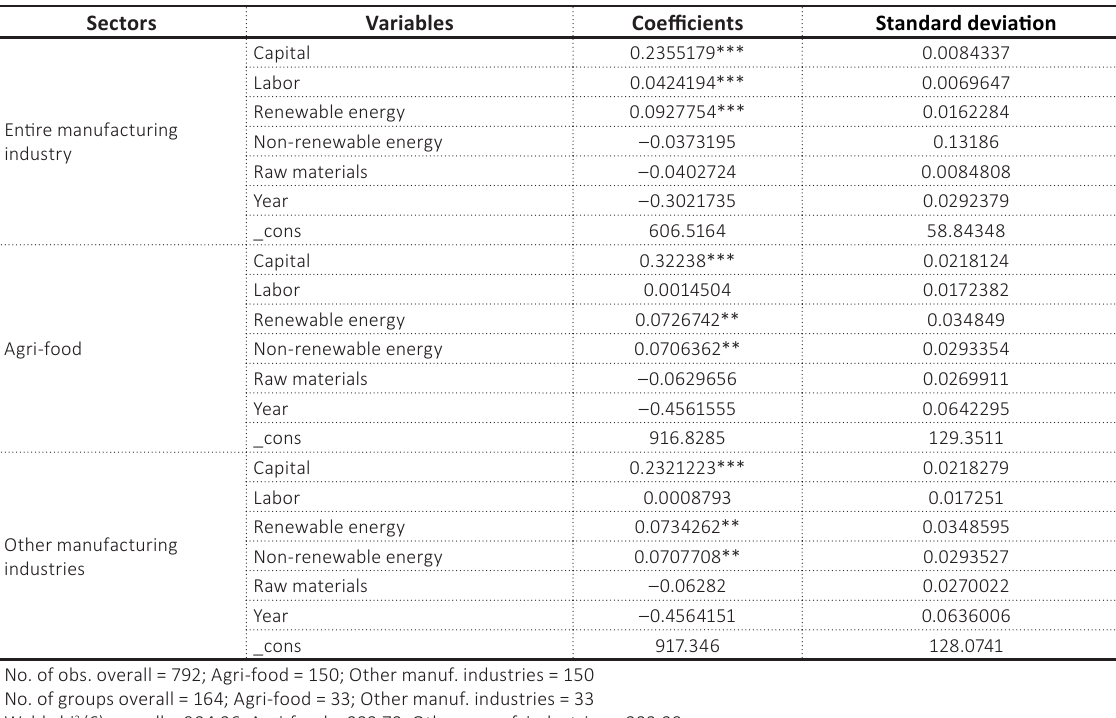
Table 3. Estimates of the effect of the form of energy on the productivity of manufacturing firms in Cameroon